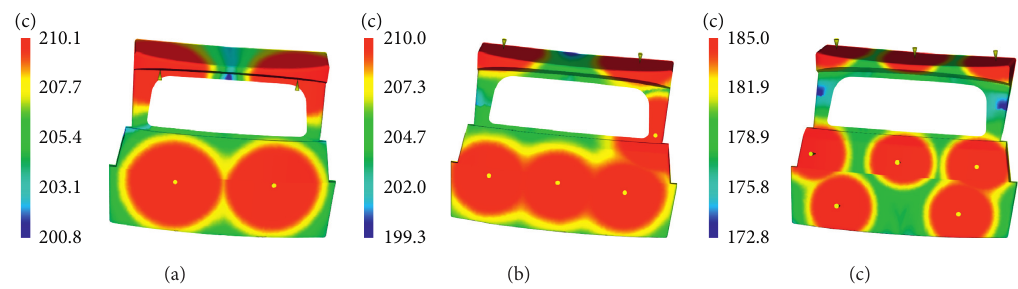
Figure 6: Flow front temperature with (a) four gates, (b) six gates, and (c) eight gates.